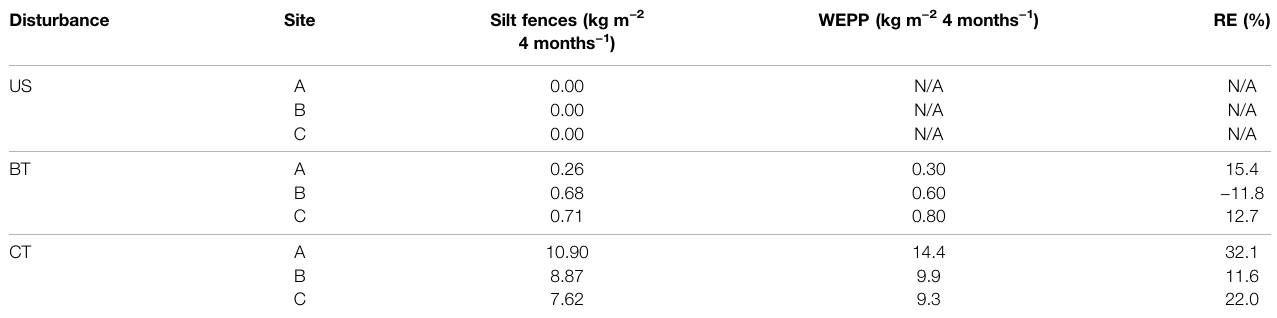
TABLE 2 | Soil erosion estimates for each disturbance collected by silt fences and predicted by WEPP. Disturbance